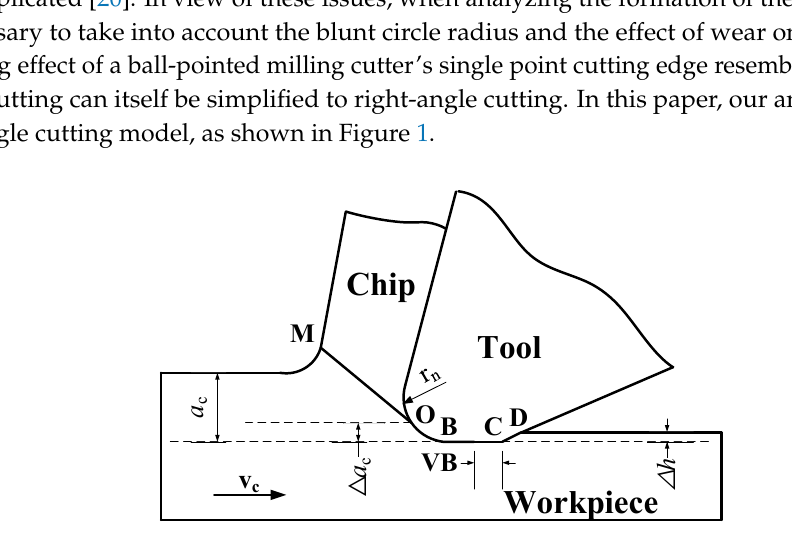
Figure 1. Formation of the machined surface.